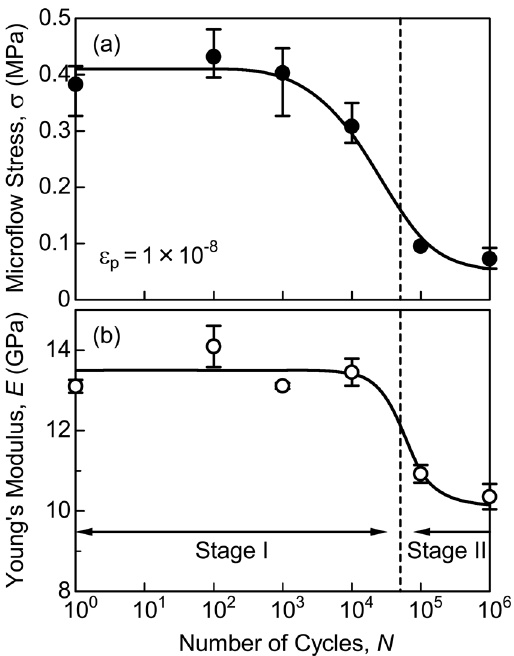
= 1×10 -8 and (b) Young's Figure 5. (a) Microflow stress σ at ε p modulus E against the number of cycles N . The dotted line shows the border between Stage I and II Further, it is of interest to compare the microflow stress with the residual stress measured by tensile testing. The residual stress for FRP samples subjected to fatigue loading usually decreases towards the end of Stage II 14 , but the microflow stress exhibits a decrease during Stage I. This large difference could be due to the fact that the residual stress is substantially determined by fiber breakage, whereas the microflow stress is related to microplastic deformation caused by microcracking and fiber pull-out. Therefore, the fatigue deterioration due to microplasticity can be detected much earlier than macroplasticity evaluated from the residual stress, while the stress levels are quite different from each